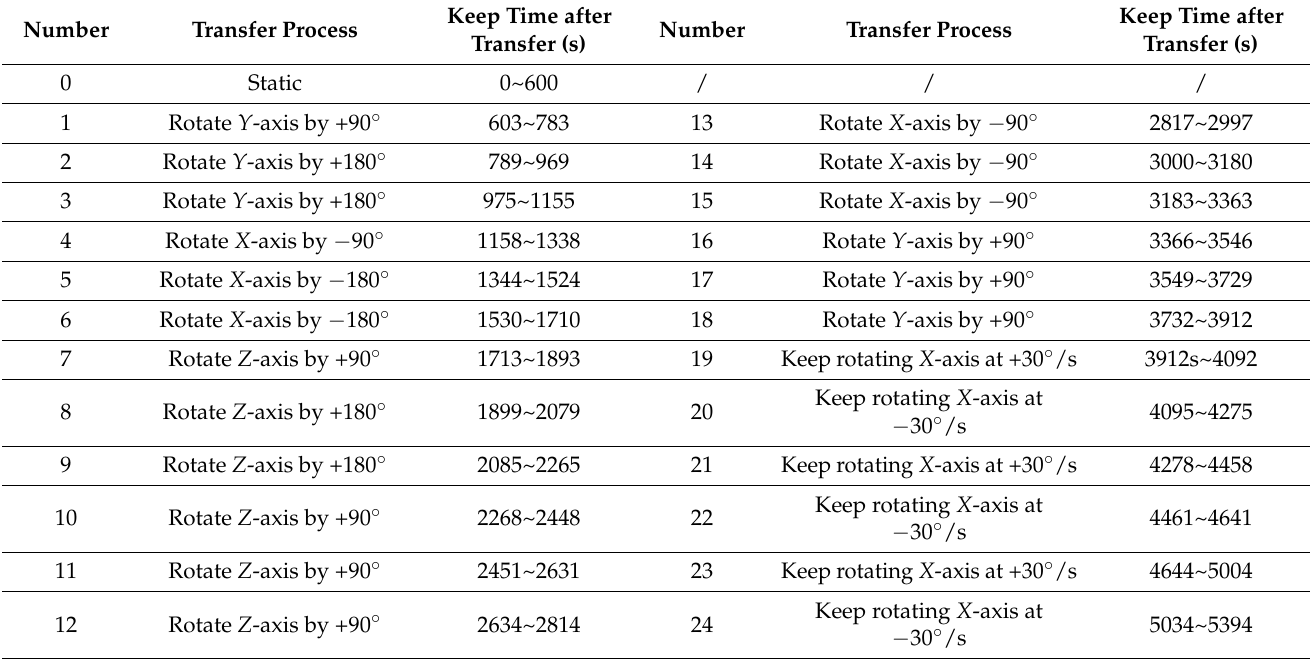
Table 1. The calibration path based on 24